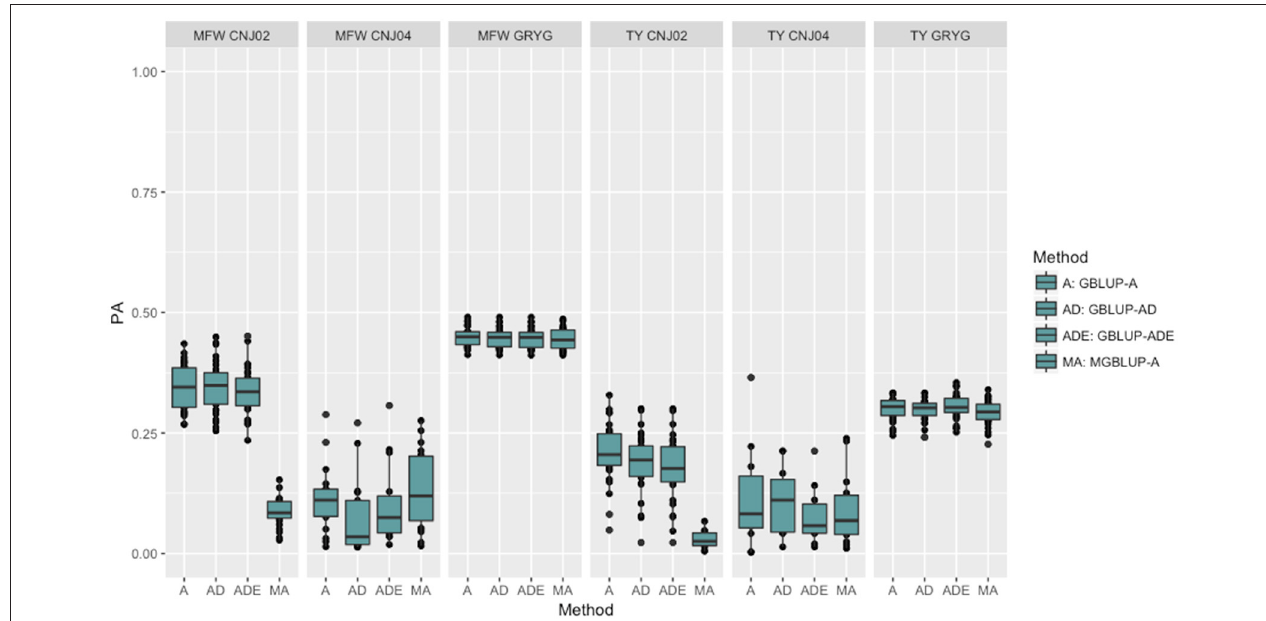
FIGURE 2 | Trait-based comparison between univariate and multivariate genomic best linear unbiased prediction methods (GBLUP and MGBLUP) for mean fruit weight (MFW) and total yield (TY) in three cranberry biparental populations. Methods within boxplots are GBLUP using only additive relationship matrix (GBLUP-A), GBLUP using additive and dominance relationship matrices (GBLUP-AD), GBLUP using additive, dominance and epistatic relationship matrices (GBLUP-ADE), and multivariate GBLUP using only additive relationship matrix (MGBLUP). MGBLUP used both traits to form the multivariate response and the genetic correlation among these responses (low or null genetic correlation scenario in our data).